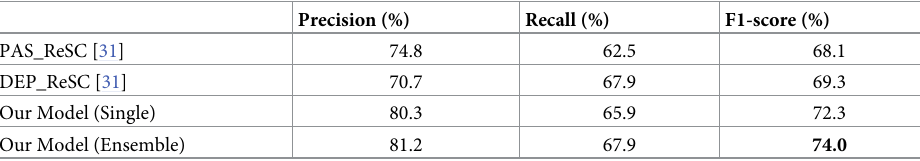
Table 9. Comparison of in vitro PK DDI results of our model and those existing models. Precision (%) Recall